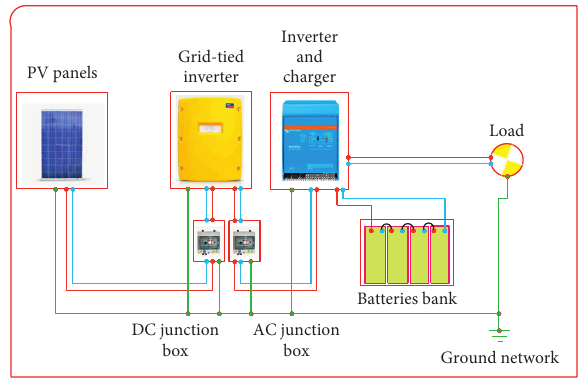
Figure 1: Synoptic diagram of the PV system at ENSET School; this one reflected the small-scale microgrid with the system of storage (batteries bank) and grid-tied inverter.